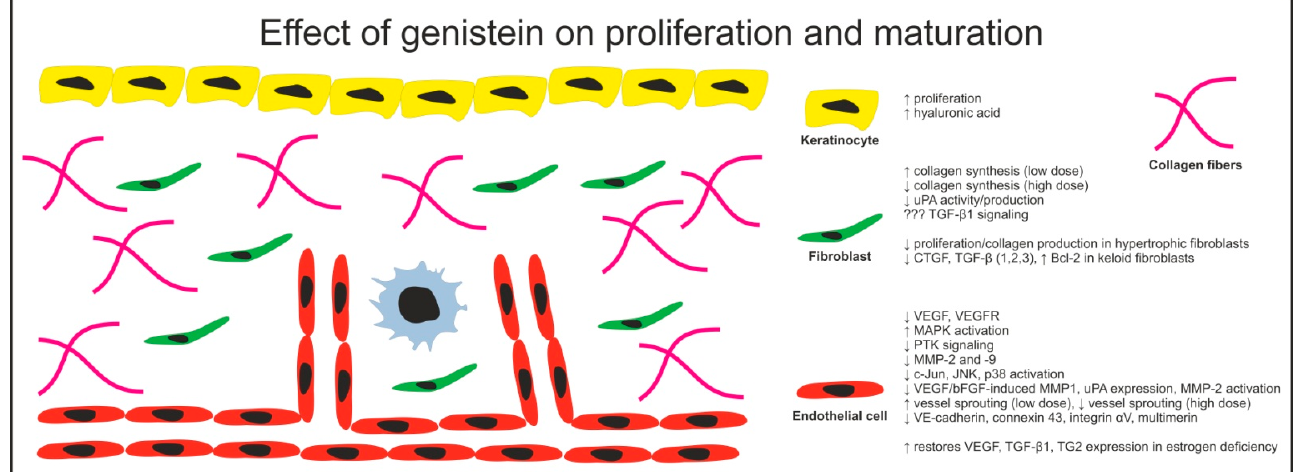
Figure 2. Cell-specific effects of genistein on wound healing during the proliferation and maturation phases.